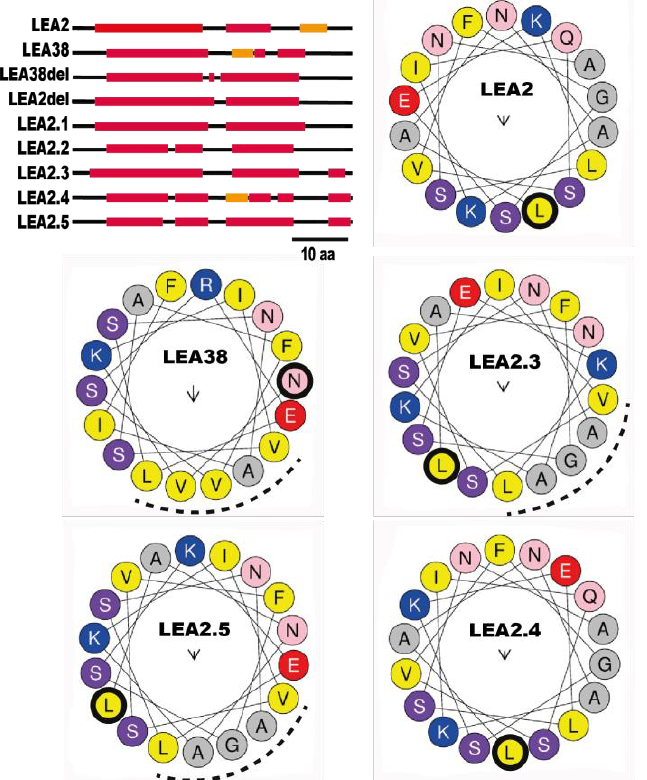
Figure 4. Secondary structure predictions for LEA2, LEA38, and mutated proteins. Secondary structure predictions for the first 50 amino acids (top left part of the figure) were performed using JPRED4 software. Red box: alpha-helix: orange box: extended strand; black line: random coil. Helical projections of α-helices were obtained using 18 amino-acids at the beginning of the first helix in the indicated proteins. The helical projections of LEA38, LEA38del, and LEA2.1, which share the same sequence in the analyzed region, are identical, as well as those of LEA2, LEA2del, and LEA2.2. The first residue is circled in black. Positively charged residues (K, R) are color coded in blue, while negatively charged residues (D, E) are in red. Non-polar residues are shown in yellow or grey and others in purple, light blue, or light pink colors. The arrow of variable size in the center of the helix shows the weight and orientation of the hydrophobic moment, and the dotted line identifies the hydrophobic face.